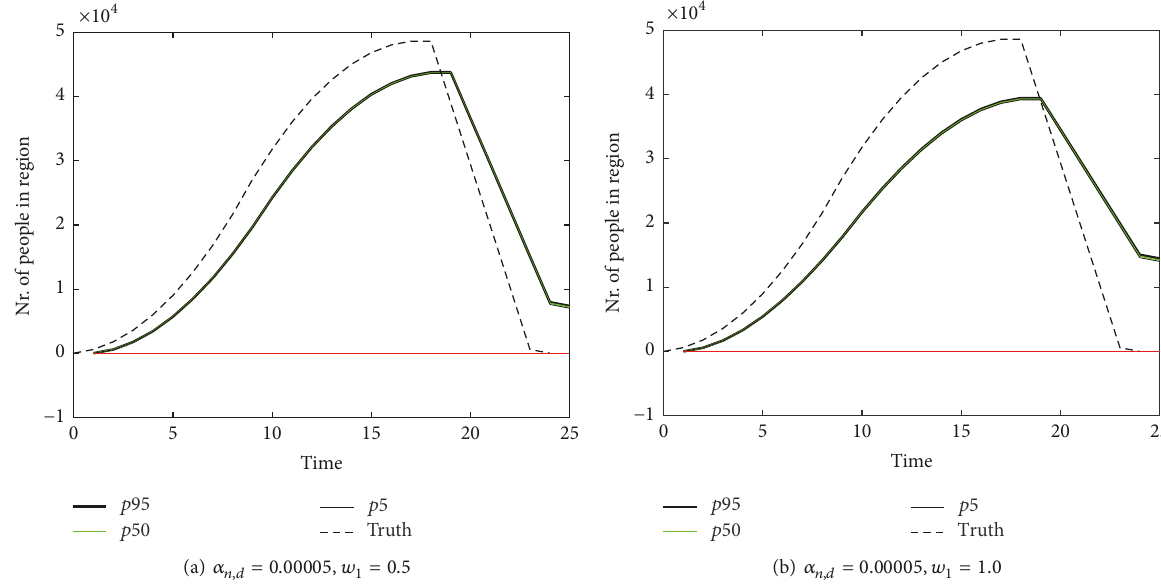
Figure 9: Case 3: visualisation of the solution space provided by the Monte Carlo simulation for given combinations of 𝛼 𝑛,𝑑 and 𝑤 1 .